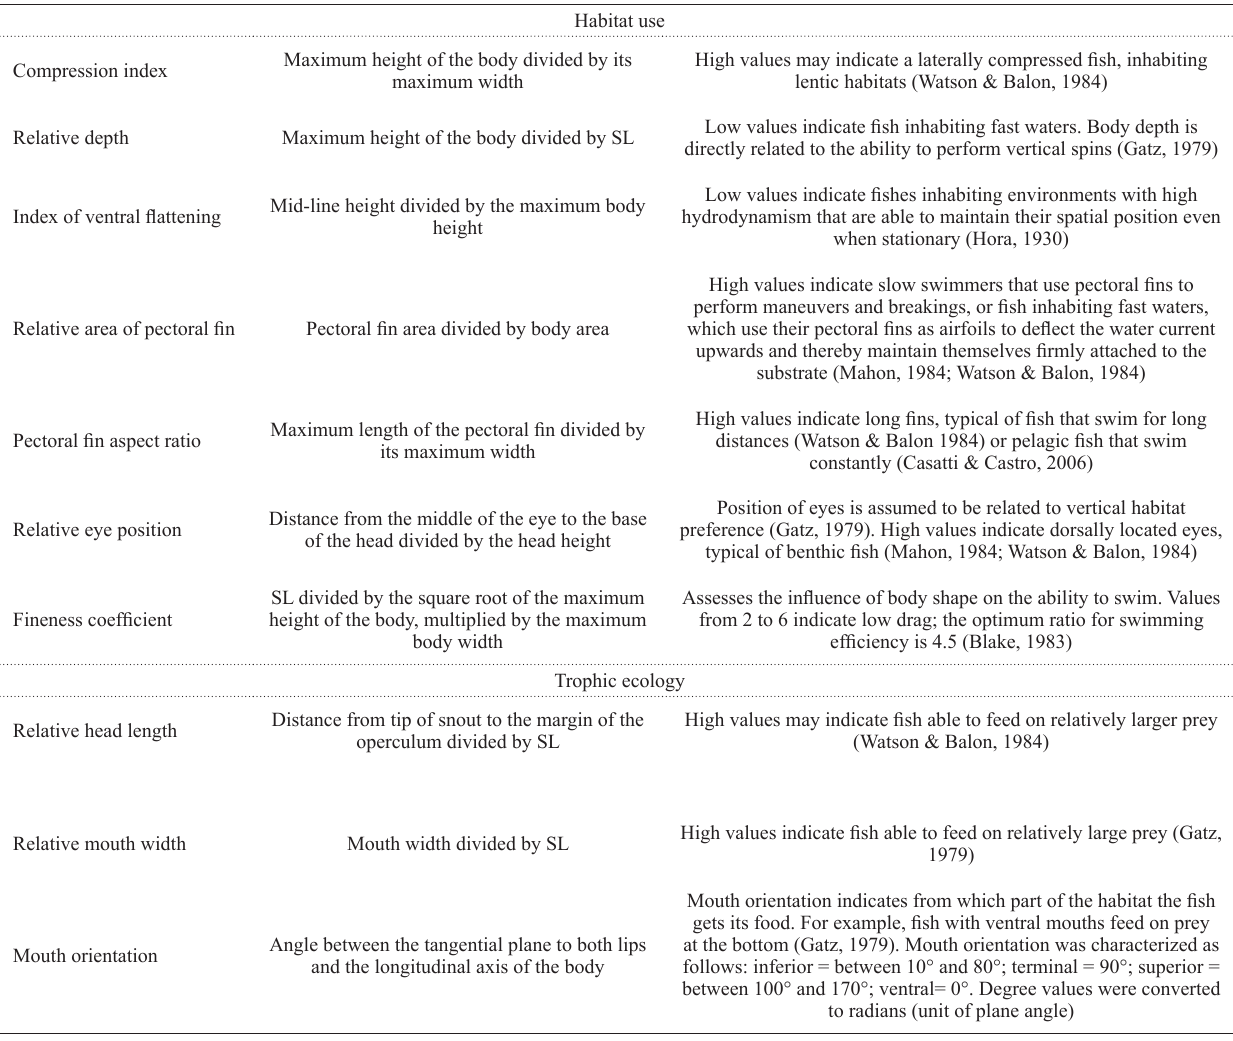
Table 1. Functional traits related to habitat use and trophic ecology. Measurements were taken according to Winemiller (1991) and Casatti & Castro (2006). SL = standard